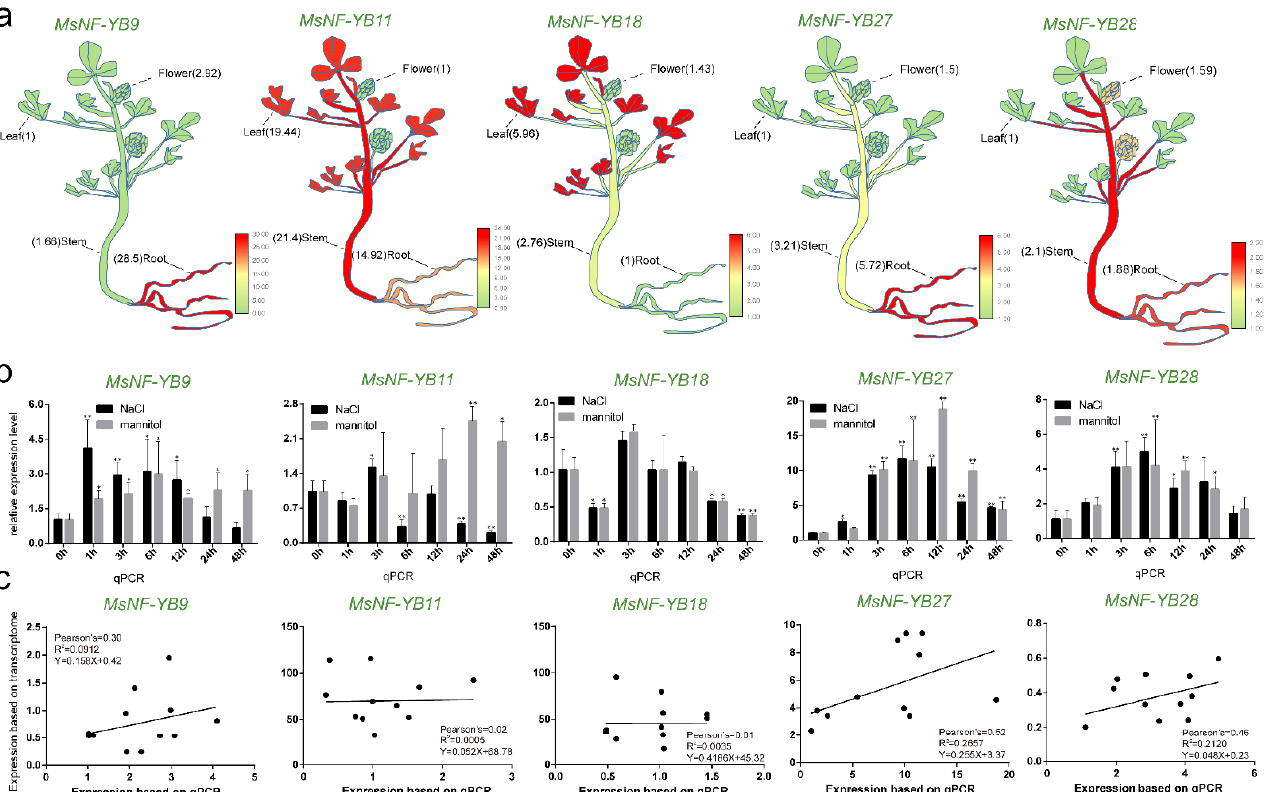
Figure 9. Quantification of gene expression levels of selected NF-YB genes from M. sativa using RT-qPCR. ( a ) Expression level of MsNF-YB genes in different tissues. ( b ) Expression level of MsNF-YB genes under NaCl and mannitol stress. Data are average of three independent biological samples ± SE, and vertical bars indicate standard deviation. ** indicates p < 0.01, and * indicates p < 0.05. ( c ) Correlation analysis of RT-qPCR and transcriptome (NaCl and mannitol) results for MsNF-YB genes. Pearson ’ s r indicates the Pearson correlation coefficient.